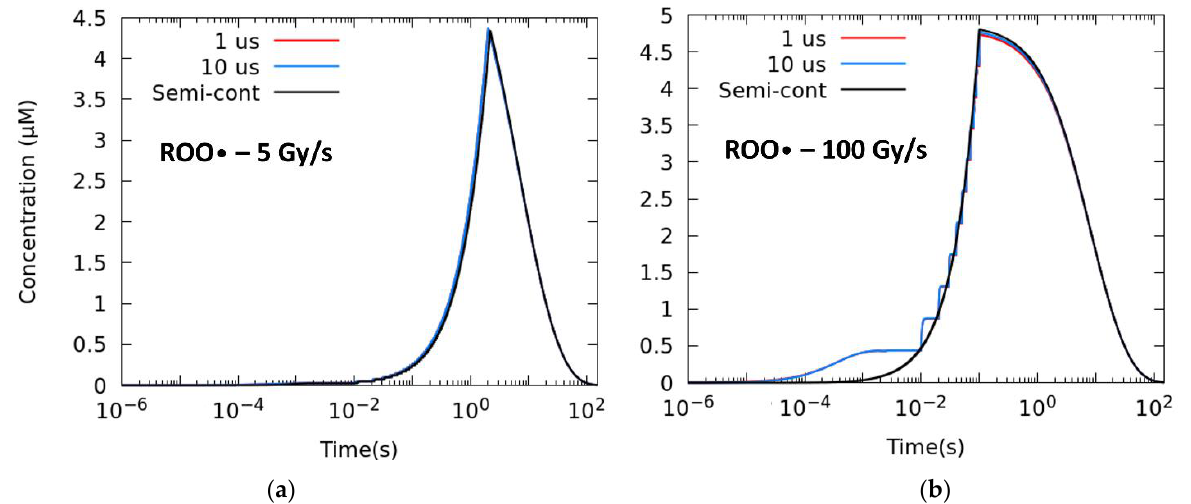
Figure 5. Time evolution of the ROO• radical at ( a ) 5 Gy/s and ( b ) 100 Gy/s with a frequency of 100 Hz and pulses of different widths. The simulations correspond to a total dose of 10 Gy.